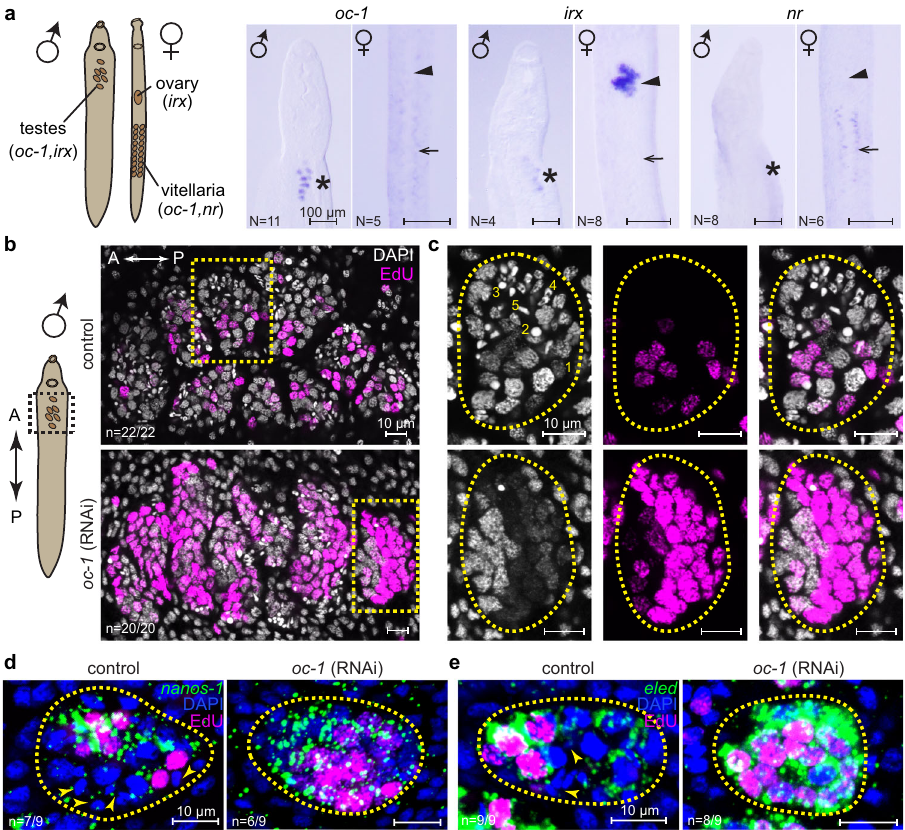
Fig. 2 oc-1 RNAi leads to over-proliferation of male GSCs. a WISH images of oc-1 , irx, and nr expression in male and female juvenile parasites. Left: schematic showing the locations of major reproductive organs in schistosome juveniles. Asterisks: primordial testes; arrowheads: ovary primordia; arrows: vitellaria primordia. N : number of samples showing similar results over two independent experiments, each using parasites collected from a separate infection. b Confocal images of DAPI/EdU-stained testes in control and oc-1 RNAi male juvenile parasites. The imaged areas correspond to the dashed box in the schematic on the left. A: anterior; P: posterior. c Magni fi ed views of individual testis lobules corresponding to yellow boxes in b . Dashed circles: testis lobule boundary. Nuclear morphologies are characteristic of each cell type 5 and labeled in the image as (1) GSC, (2) spermatocyte, (3) round spermatid, (4) elongating spermatid, and (5) sperm. Stage 2-5 are considered as differentiated germ cells. Note the increased fraction of EdU + nuclei and reduced number of nuclei corresponding to differentiated germ cells after RNAi compared to controls. Quanti fi cations of EdU + nuclei abundance, GSC number density, and the fraction of differentiated germ cells are provided in Fig. 3c-e along with other RNAi experiments for direct comparison. d , e FISH images showing broader expression of nanos-1 ( d ) and eled ( e ) in testes after oc-1 RNAi. Arrowheads: differentiated germ cells that do not express nanos-1 or eled . n : number of samples exhibiting the reported phenotype out of the total number of samples analyzed. RNAi experiments were repeated on at least three biological